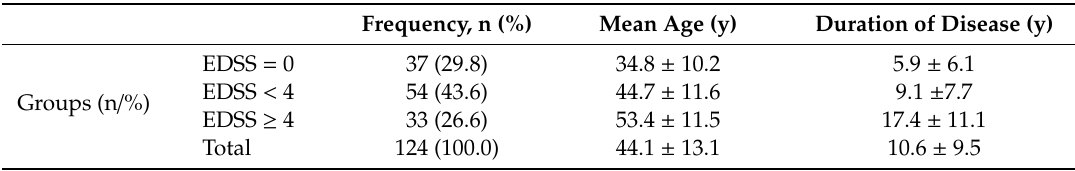
Table 2. EDSS distribution of patients with